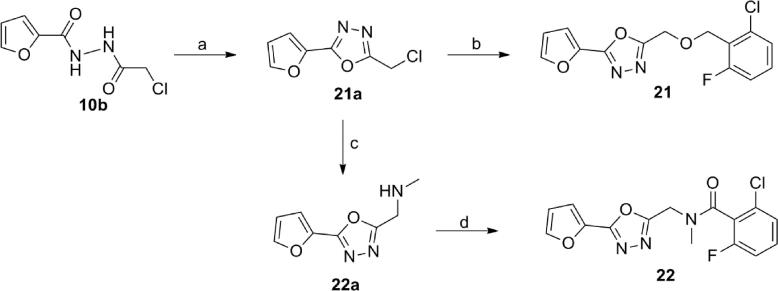
Synthesis of compounds 21 and 22. Reagents and conditions: (a) phosphoryl chloride; (b) (2-Chloro-6-fluorophenyl)methanol, NaH, THF; (c) MeNH2, NaI, CH3CN, reflux; (d) 2-Chloro-6-fluorobenzoic acid, HATU, Et3N, DMF.